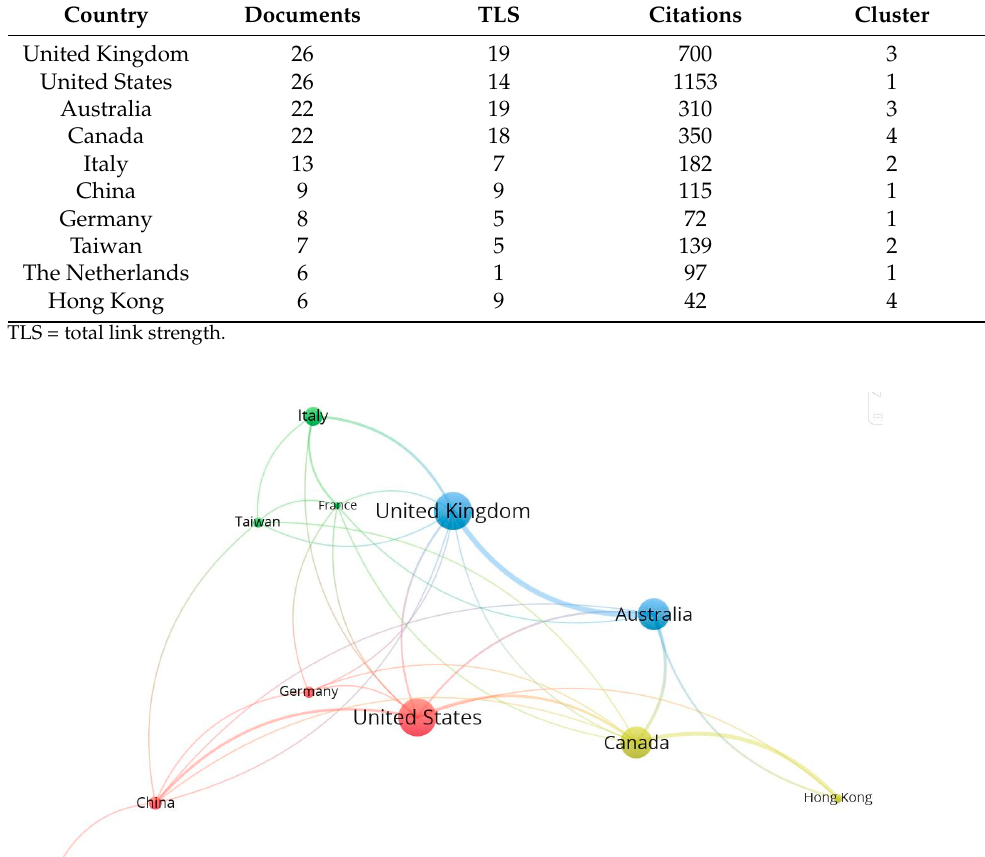
TLS = total link strength. Table 4. Top 10 most active countries based on co-authorship.